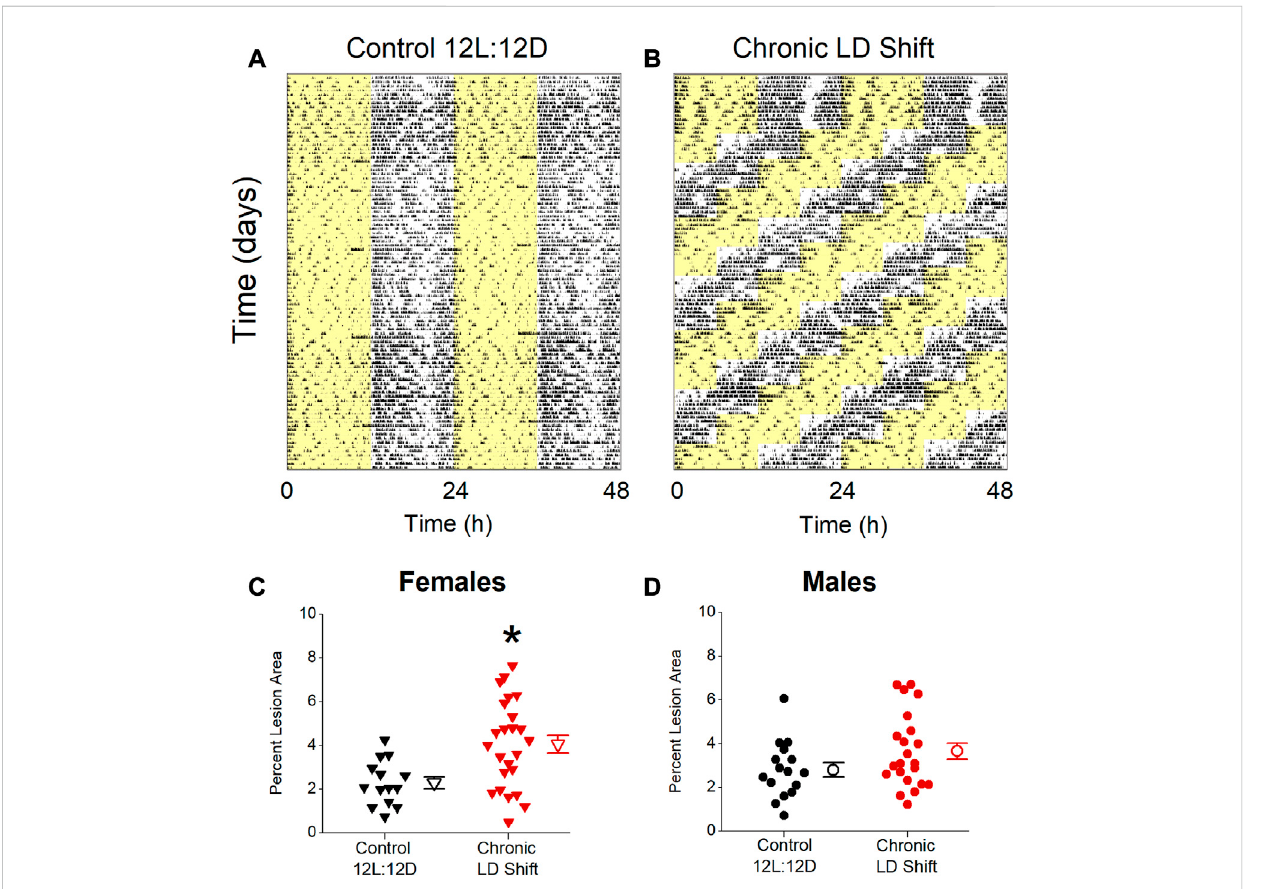
FIGURE 1 ChronicLDshiftsincreasedatherosclerosisinfemale,butnotmale, ApoE − / − mice.Representativeactogramsofgenerallocomotoractivityrecorded from ApoE − / − micehoused incontrol12L:12D (A) or chronicLDshift (b,timeof lights offadvanced 6 heach week)conditionsand fedlow-fatdiet.Yellow shadingshowslightson.Percentatheroscleroticlesionareainfemale (C) andmale (D) ApoE − / − micehousedincontrol12L:12D(blacksymbols)orchronic LD shifts (red symbols). (C,D) individual mice are closed symbols and open symbols are mean ± SEM. * p = 0.01.